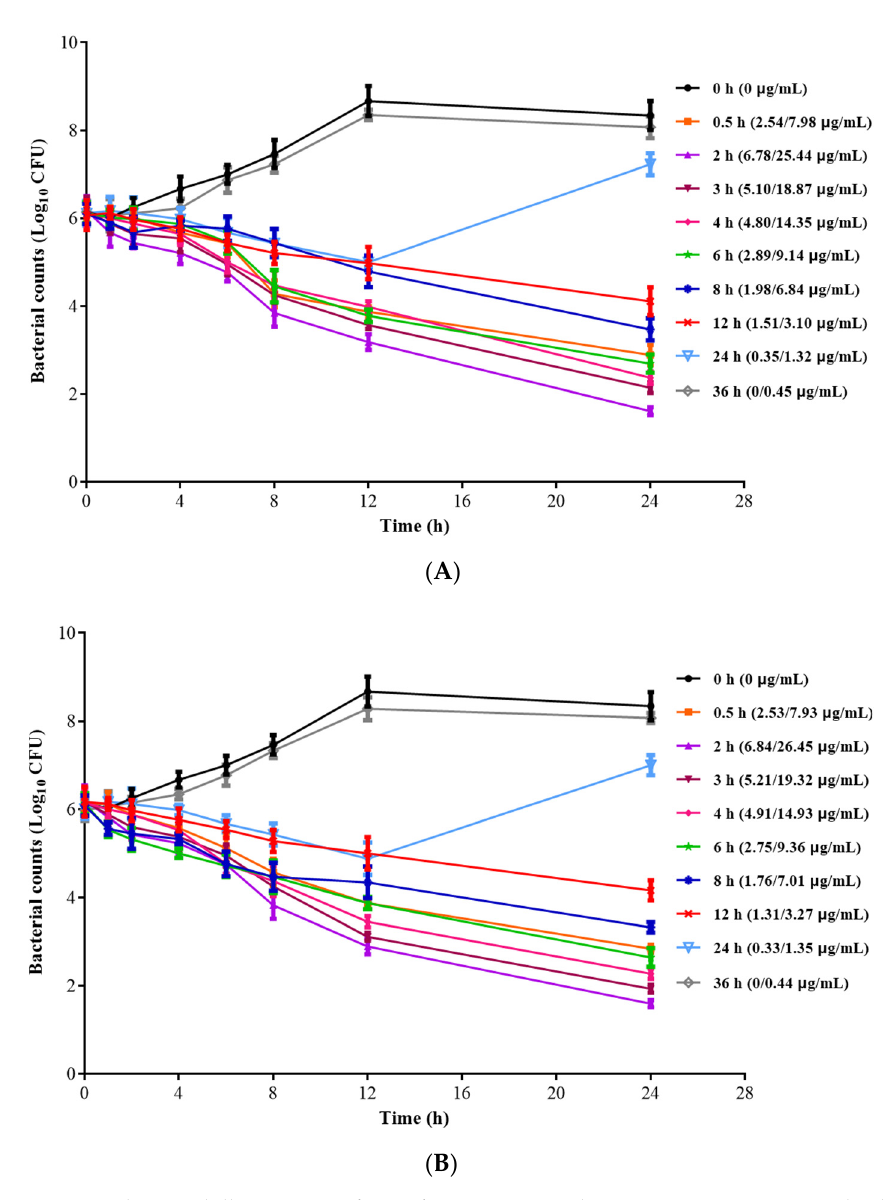
Figure 4. The time killing curves of ADP/SMZ compound against G. parasuis H78 in healthy ( A ) and infected ( B ) pigs PELF.